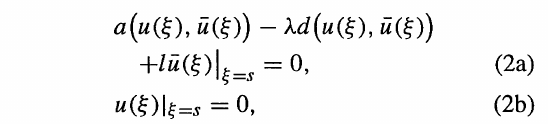
where A,F denotes the sensitivity due to the deploy ment of the free end. Equation (5) is also satisfied when the constraints located at the end of the beam because the deployed part is also free, as shown in Fig.